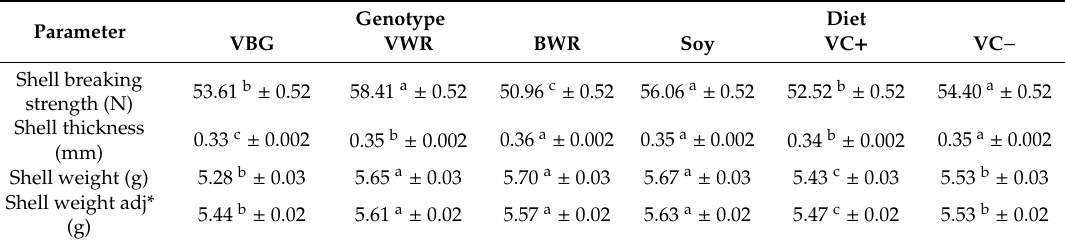
Table 4. LS-means ± SE for eggshell breaking strength, shell thickness and shell weight in crossbreds (experiment